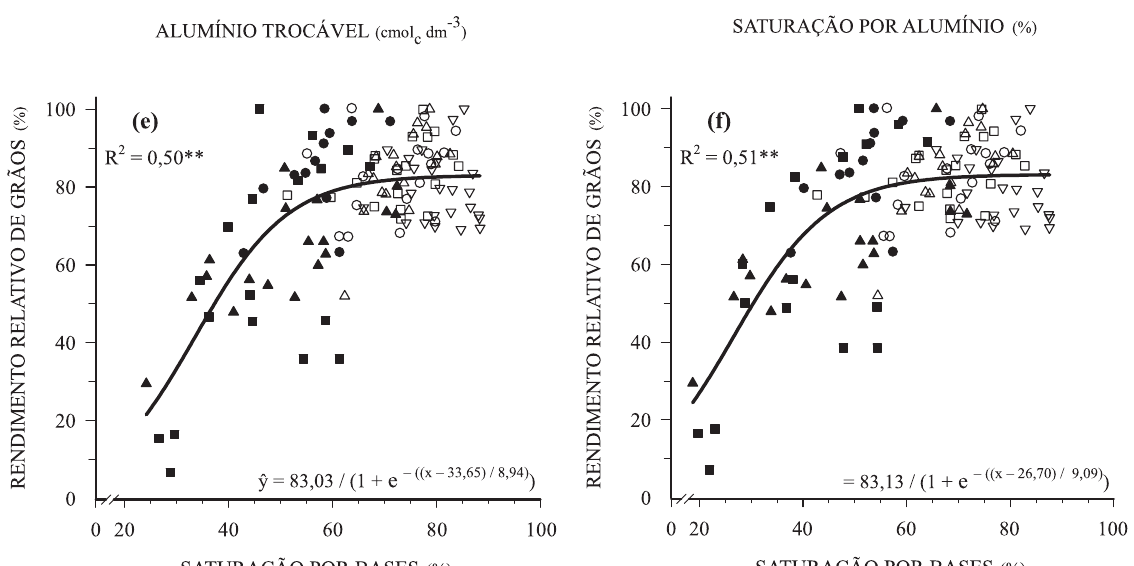
Figura 1. Relação entre o rendimento relativo de grãos e os indicadores de acidez do solo na camada de 0 a 20 cm de profundidade em lavouras no sistema plantio direto: (a) pH em água; (b) pH em CaCl alumínio trocável; (d) saturação por alumínio e saturação por bases; (e) Eq. Escosteguy & Bissani (1999) e (f) Eq. Kaminski et al.